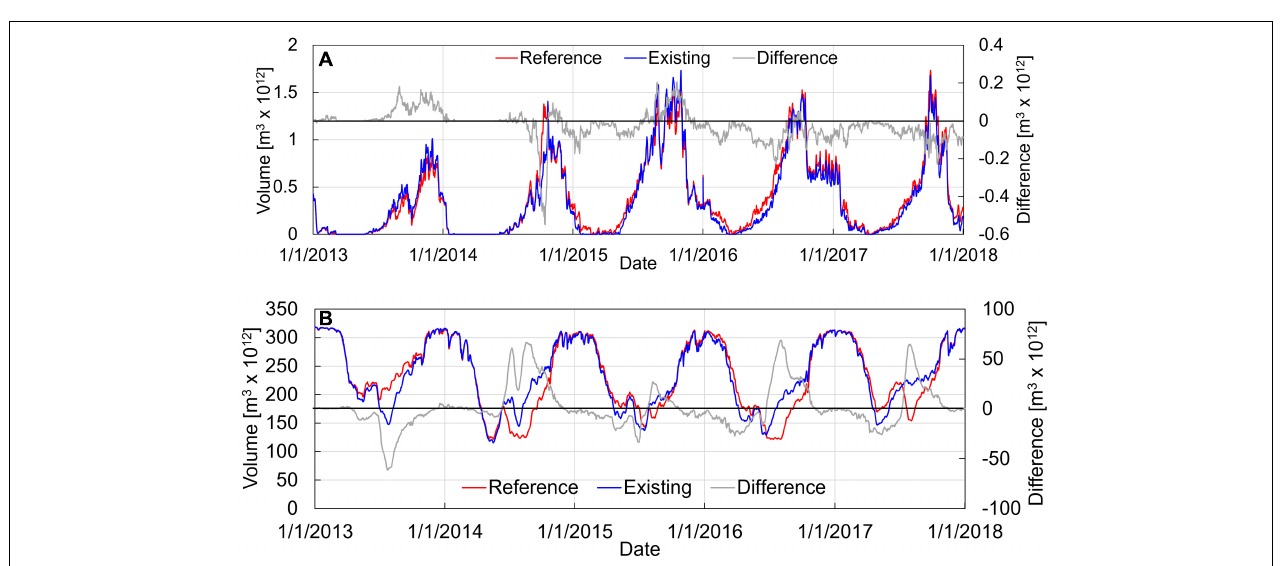
FIGURE 11 | Time series of (A) volume of hypoxic water (DO < 2 mg/L) and (B) acidic water ( (cid:127) A < 1) in the Salish Sea region including Puget Sound, Strait of Juan de Fuca, and Georgia Strait. The blue line represents model results for the existing conditions including the marine heatwave warming. The red line represents reference conditions without marine heatwave-related warming. The gray line represents the difference between existing and reference conditions showing the perturbation due to the heatwave.